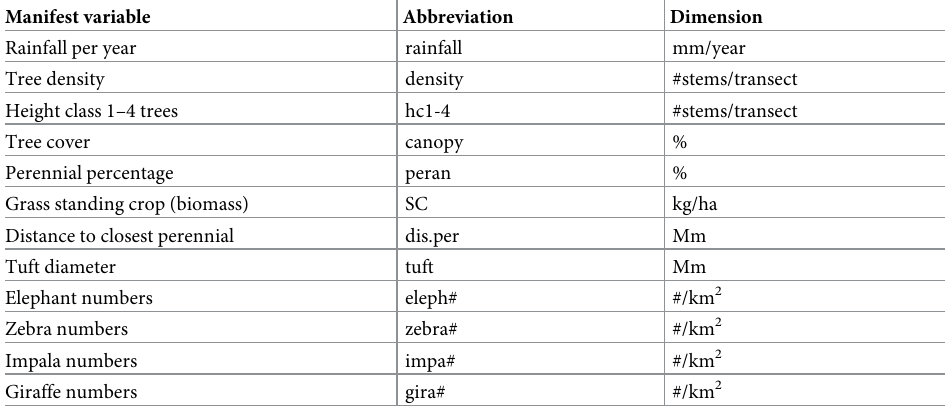
Table 2. All measured manifest variables used in the analyses with abbreviations and dimensions. Manifest